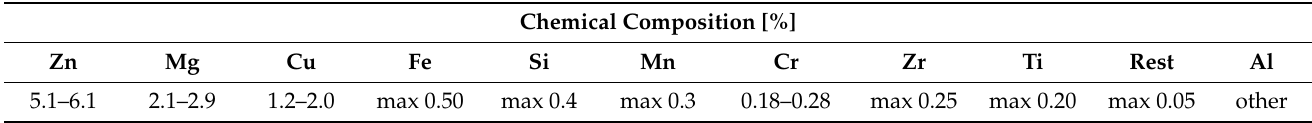
Table 1. Chemical composition of AW-7075 alloy, % by